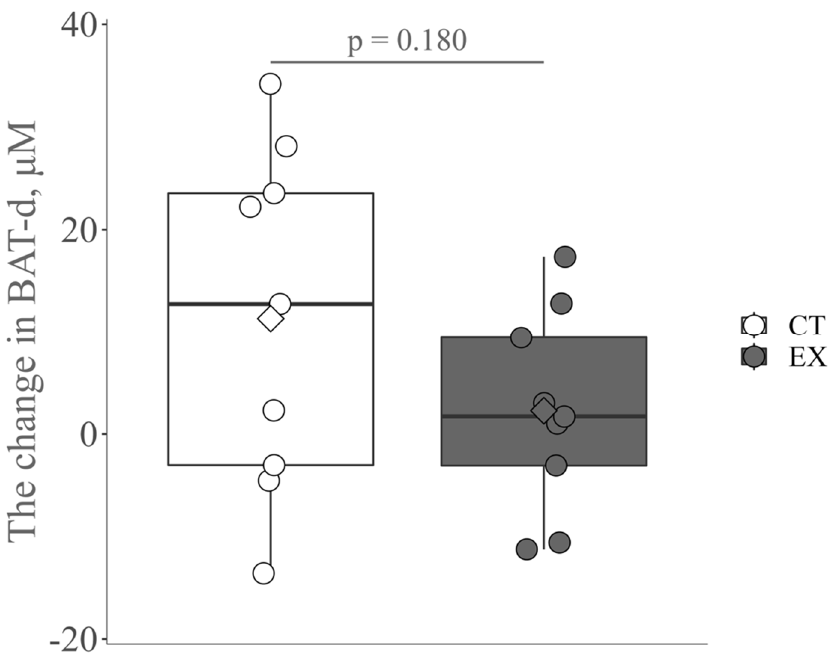
Figure 2. The change in brown-like adipose tissue vascular density (BAT-d) pre- and post-intervention